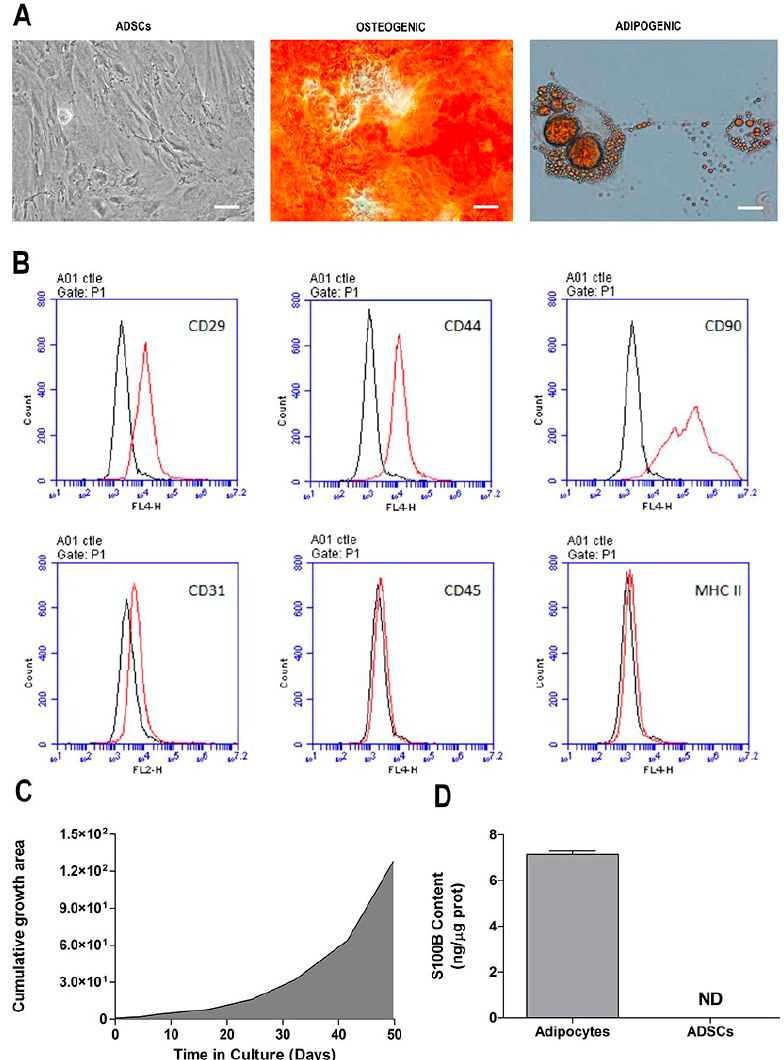
Figure 1. Morphological and phenotypic characterization of adipose-derived stromal cell (ADSC) cultures. ( A ) Cell morphology (first panel) and adipogenic and osteogenic differentiation of ADSCs (second and third panels, respectively) at 40× magnification using phase-contrast microscopy. Scale bar = 30 µM; ( B ) immunophenotyping of ADSCs by flow cytometry; peaks are the expression of the selected molecules (black trace), compared to the negative isotype control (red trace); ( C ) curve of ADSC in vitro growth over time; ( D ) S100B protein content in ADSCs and adipose tissue, as measured